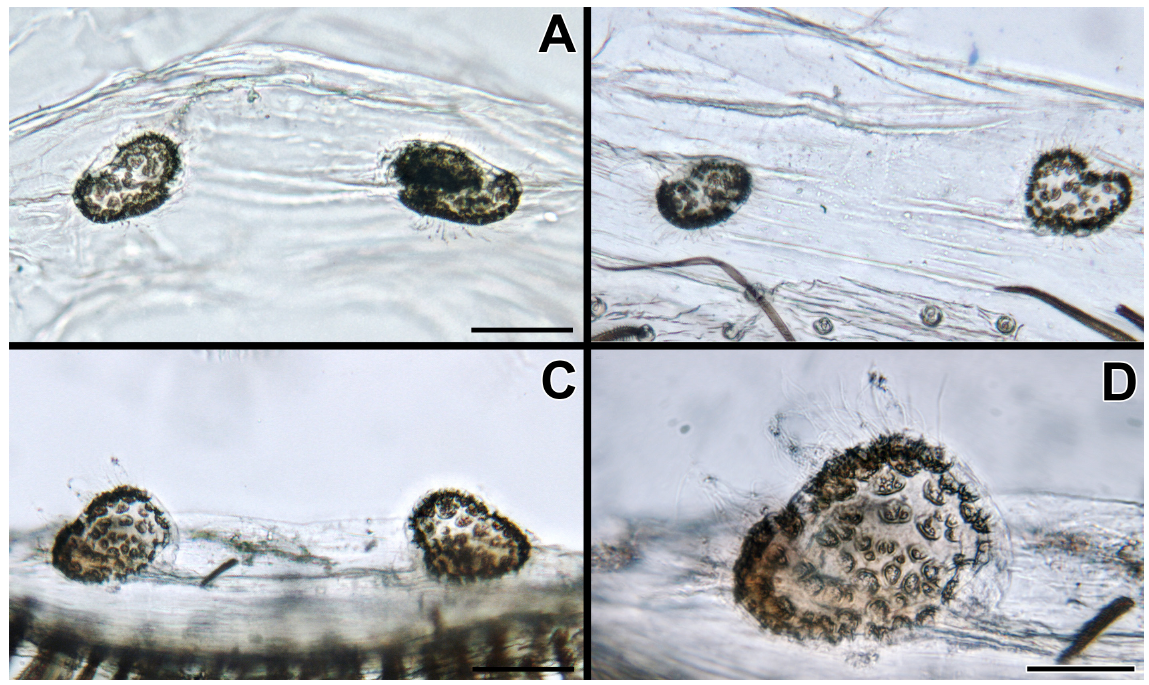
Fig. 9. Filistata betarif sp. nov., female spermathecae, ventral. A . Oah cave (HUJ-INVAr 21055). B . Tinshemet cave (MACN-Ar 41222). C–D . Tinshemet cave (MACN-Ar 41791). Scale bars: A–C = 0.2 mm; D = 0.05